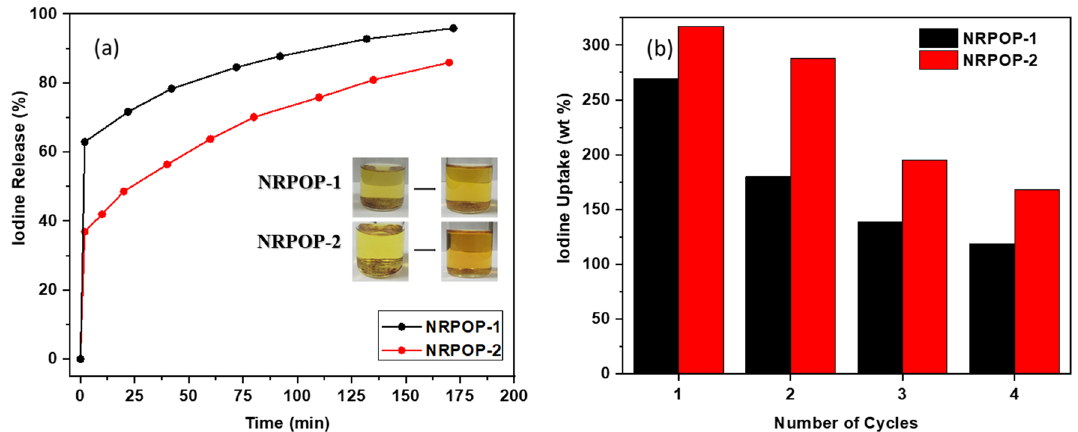
Figure 7. Percentage of iodine released from the NRPOPs by immersion in ethanol ( a ) and recyclability of NRPOPs for iodine vapor uptake